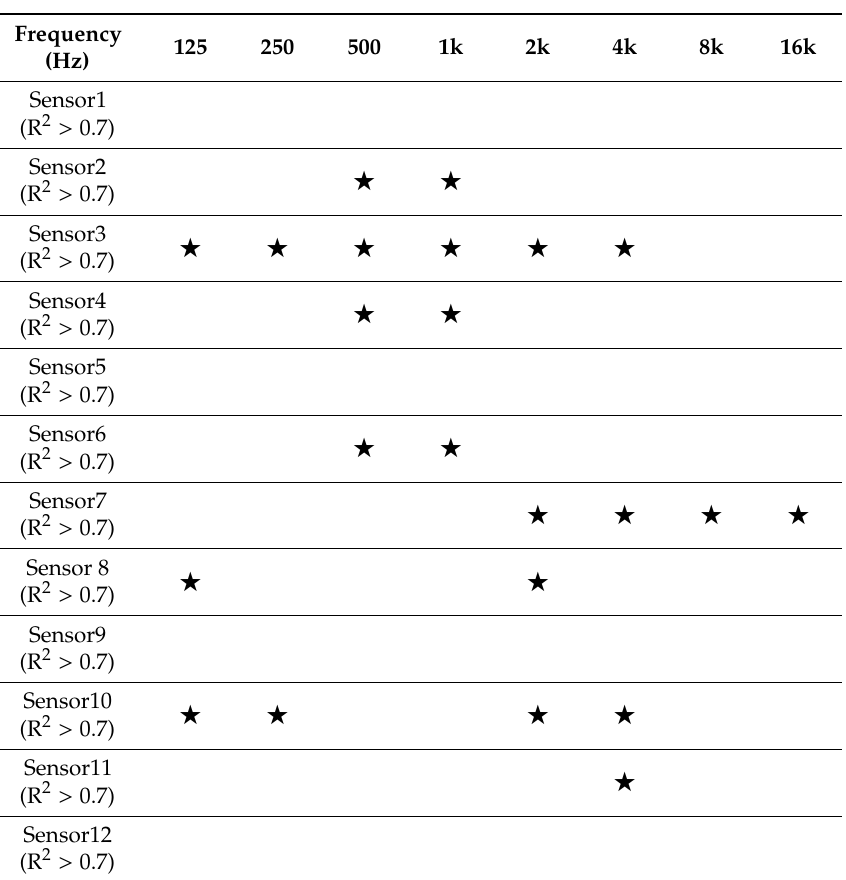
Table 2. All sensors with R 2 greater than 0.7 at all